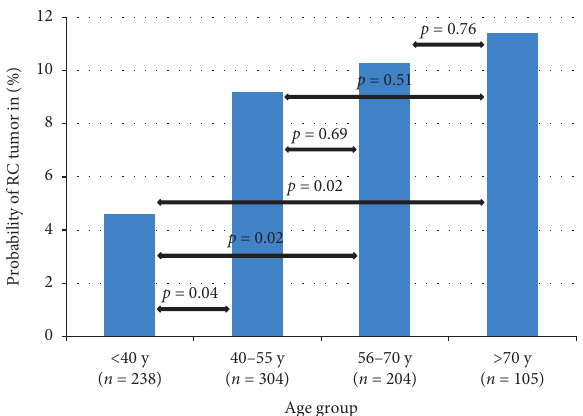
Figure 1: The frequency/proportion of tumors with a RC tumor per age group in localized disease. Overall p value by the Chi- square test p � 0 .